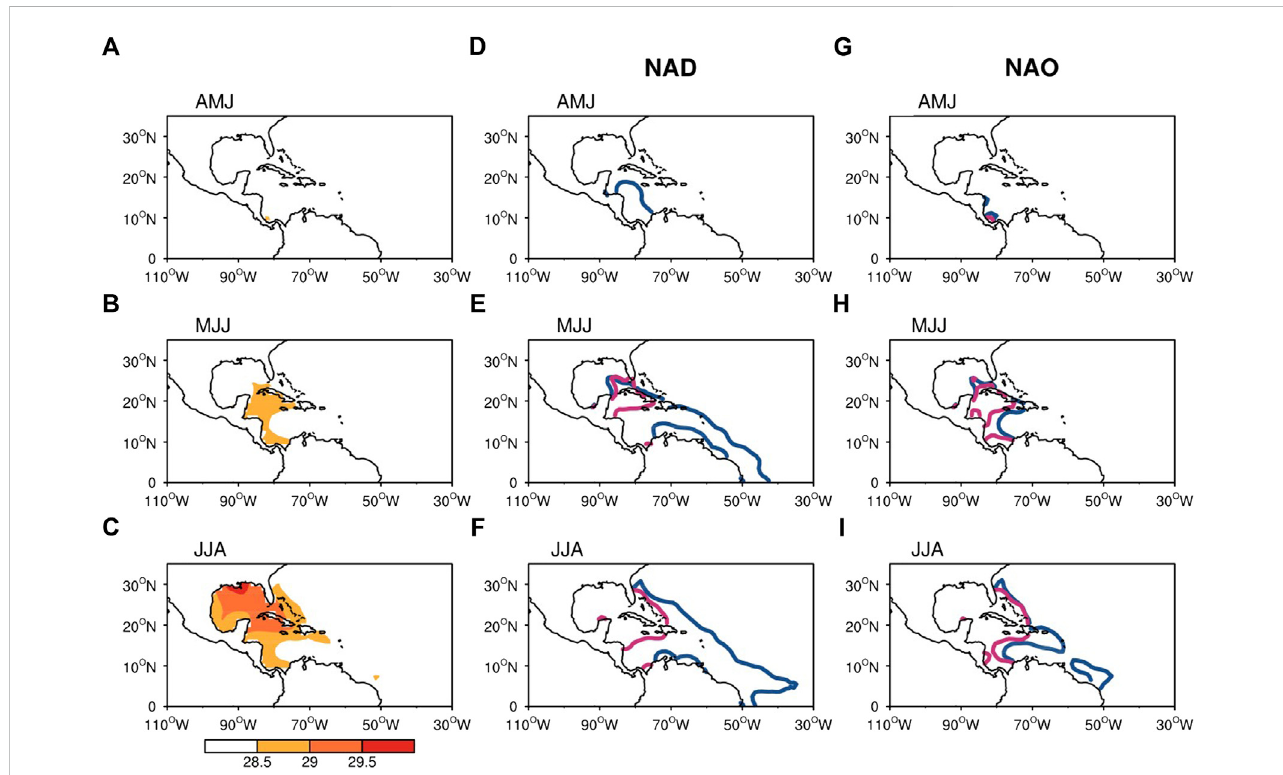
FIGURE 5 (A – C) Seasonal 3-month-averaged distributions of SST of the 28.5 ° C, 29.0 ° C, 29.5 ° C isotherm (the climatic state); (D – F) Composite of following 3- month-averaged SST of the 28.5 ° C isotherm from positive NAD cases (red line) and negative NAD cases (blue line); (G – I) as in (D – F) but from positive NAO cases (red line) and negative NAO cases (blue line).